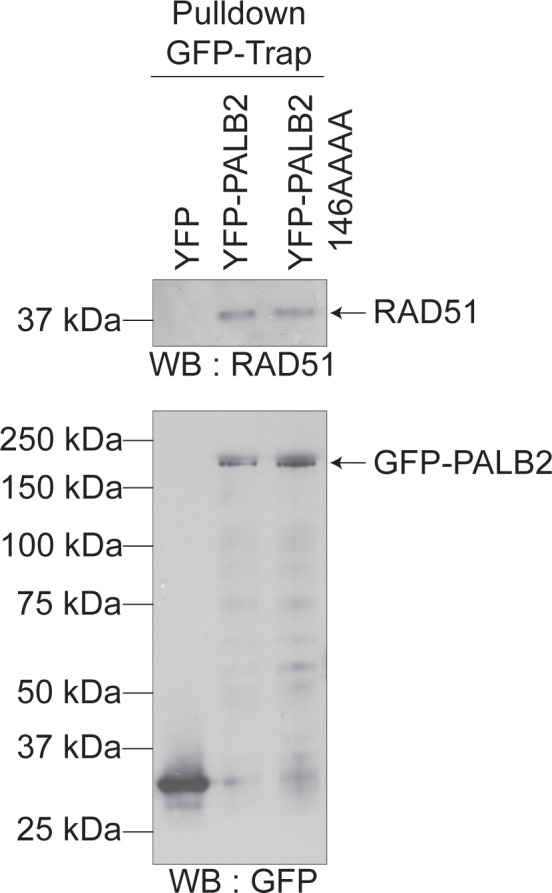
YFP-PALB2 and YFP-PALB2 146AAAA binds RAD51 equally.Lysates from HEK293T cells expressing the indicated constructs were subjected to GFP-Trap pulldown and immunoblotting against YFP or RAD51. YFP alone was used as a negative control.